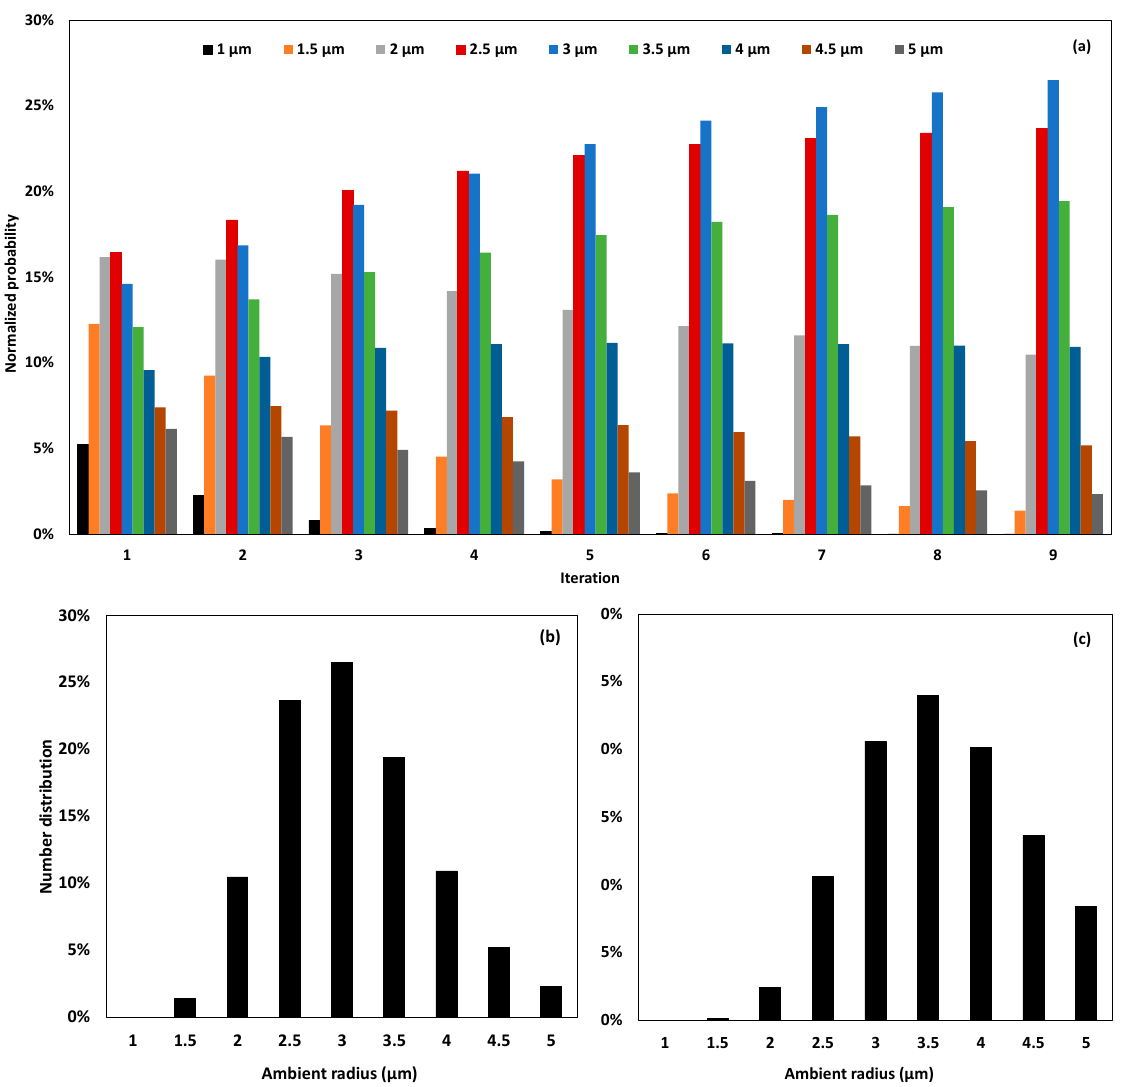
Figure 6. Normalized probability of equilibrium radii at successive iteration until convergence ( a ), final number distribution ( b ), and final volume distribution ( c ).